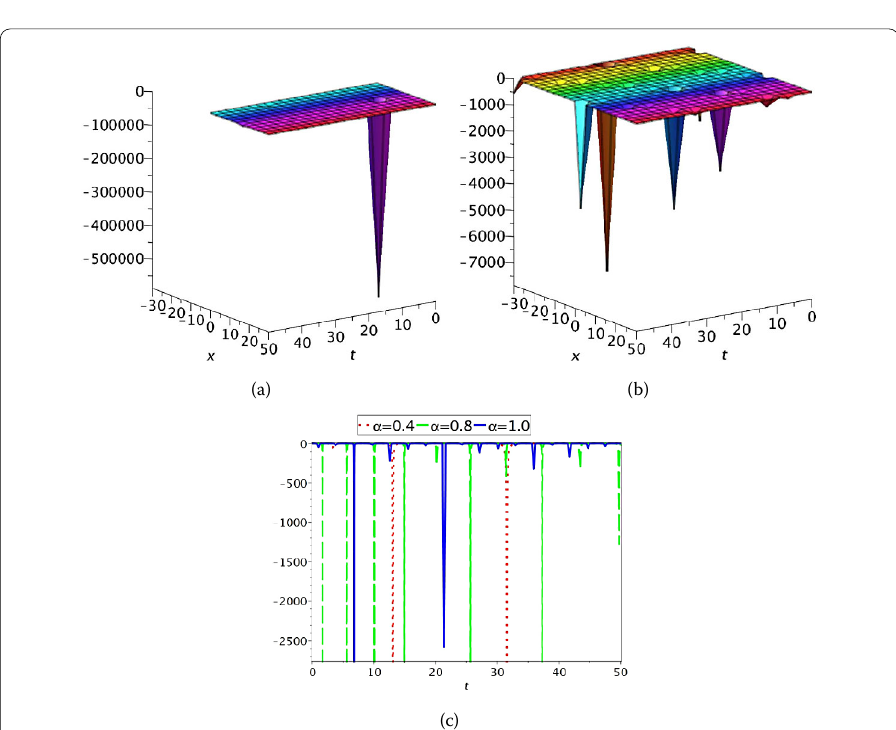
Figure 12 Hyperbolic solution of u 2,7 ( ξ )